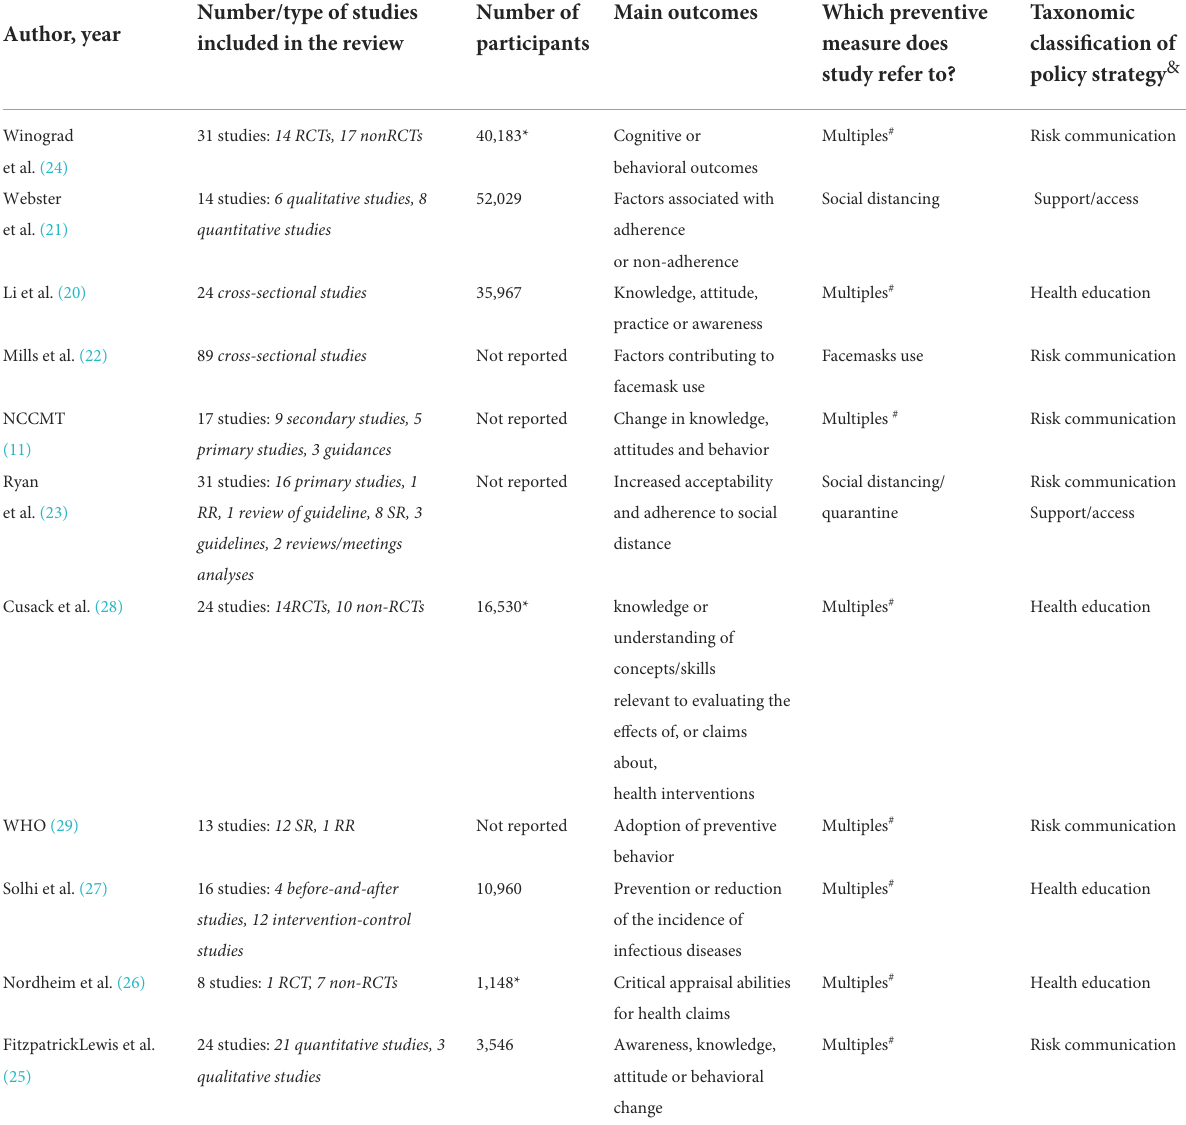
TABLE 1 Characteristics of the studies included for identifying policy